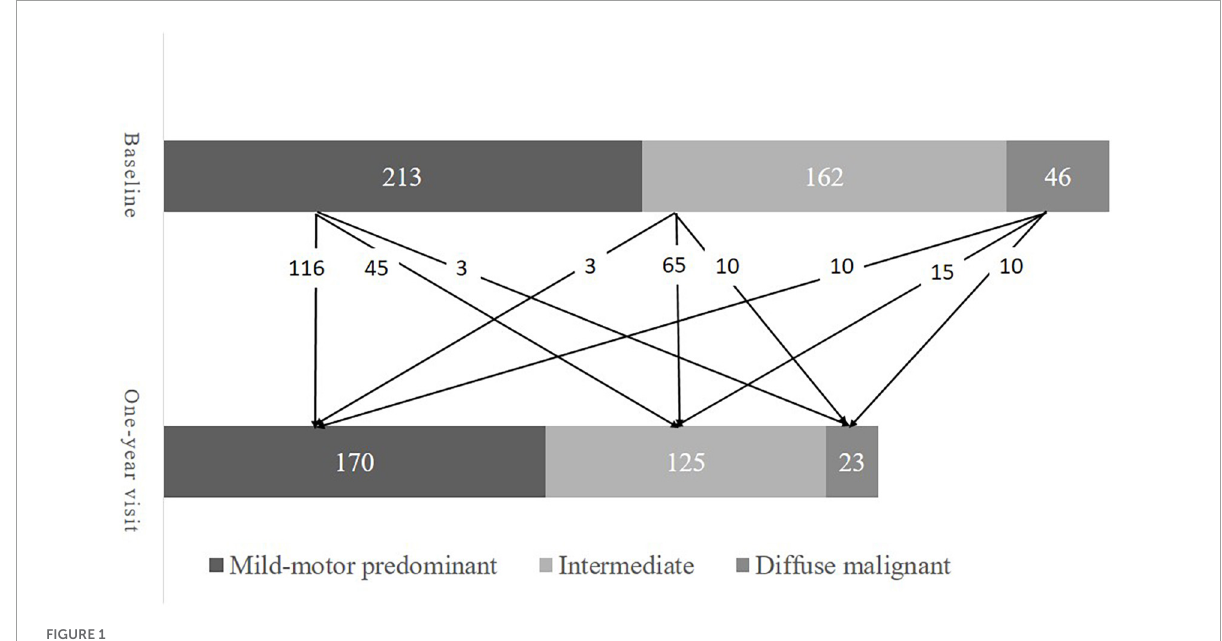
FIGURE1 Subtype change from baseline to one-year visit.